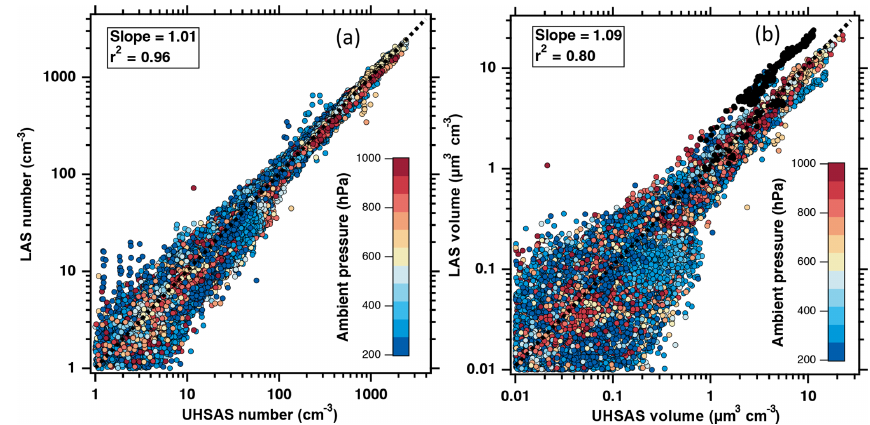
Figure 7. (a) Integrated 10s average particle number concentrations from 0.104 to 0.97µm diameter from the UHSAS and LAS instruments for all of the ATom-1 deployment. (b) As for (a) , but for integrated particle volume. Colors indicate ambient pressure. Slopes from two-sided least-squares regressions forced through a zero intercept are shown. Values of r 2 are from a one-sided linear least-squares regression. Black points in the volume plot show periods of dust from Africa.